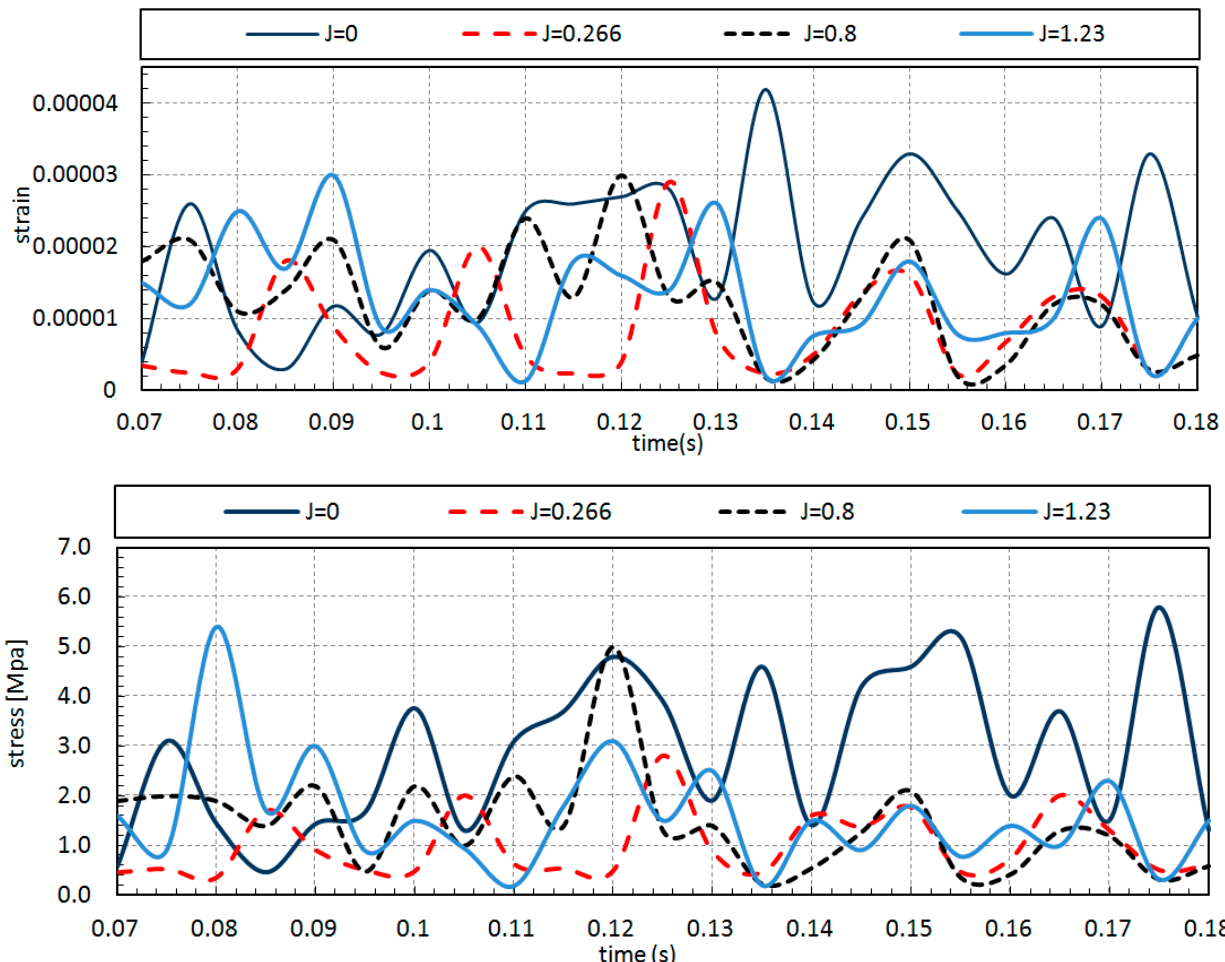
Figure 10. Maximum stress and strain values, for two revolutions, at J = 0, 0.266, 0.8, 1.23.